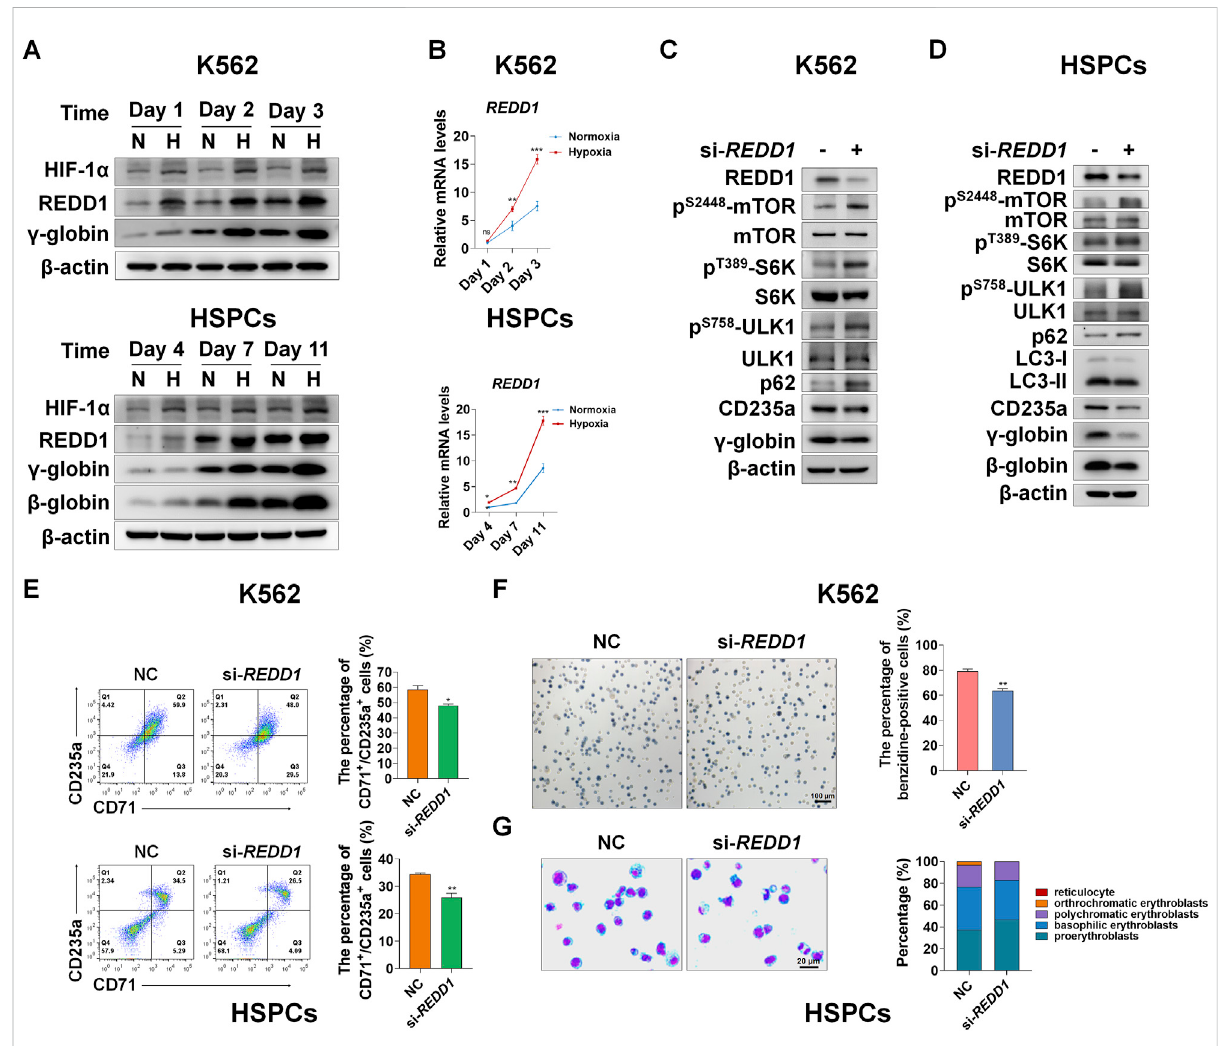
FIGURE 5 REDD1 upregulates autophagy through inhibition of mTORC1 signaling under hypoxia (A) Western blot analysis of HIF-1 α and REDD1 protein expression atthe indicated time points after K562 cells- and HSPCs-differentiated erythrocytes were exposed to normoxia or hypoxia. N: normoxia; H: hypoxia (B) qRT-PCR analysis of the relative mRNA levels of REDD1 in K562- and HSPCs-differentiated erythrocytes under normoxia or hypoxia. ** p < 0.01, *** p < 0.001, versus the respective normoxia group at different time points (C,D) Western blot analysis of the effects of REDD1 knockdown on p62, LC3, CD235a, γ -globin or β -globin protein levels and mTORC1 activity in K562 cells- or HSPCs-differentiated erythrocytesculturedunderhypoxia (E) FlowcytometryplotsshowtheeffectsofREDD1knockdownonCD71andCD235aexpressioninK562cells- and HSPCs-differentiated erythrocytes under hypoxia, respectively. The respective graph on the right shows the percentage of CD71 + /CD235a + cells. * p < 0.05, ** p < 0.01, versustheNCgroup (F) Representative images ofbenzidinestainingon the3rddayofdifferentiation ofK562 cellswith or without REDD1 knockdown underhypoxia. ScaleBar =100 μ m.The graph ontherightshows thepercentage ofbenzidine-positive cells. ** p < 0.01, versus the NC group (G) May-Grunwald Giemsa staining on the seventh day of differentiation of HSPCs shows the effect of REDD1 knockdown